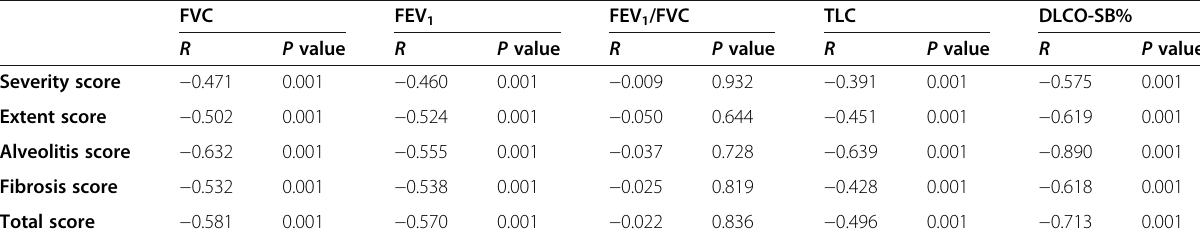
Table 5 Correlation between Warrick ’ s score and different pulmonary function indices among the studied population